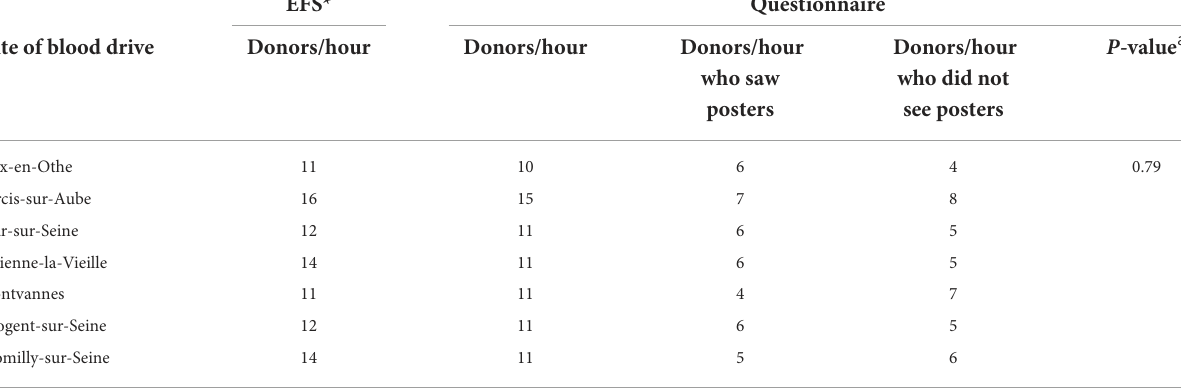
TABLE 3 Comparison of the number of donors per hour, and of those who had or had not seen the advertising posters in a GP’s waiting room.